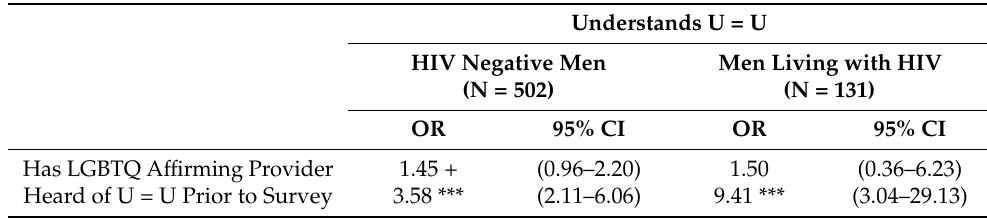
Table 7. Estimates of understanding of U = U among a sample of midlife and older gay and bisexual men in the US south by HIV status,